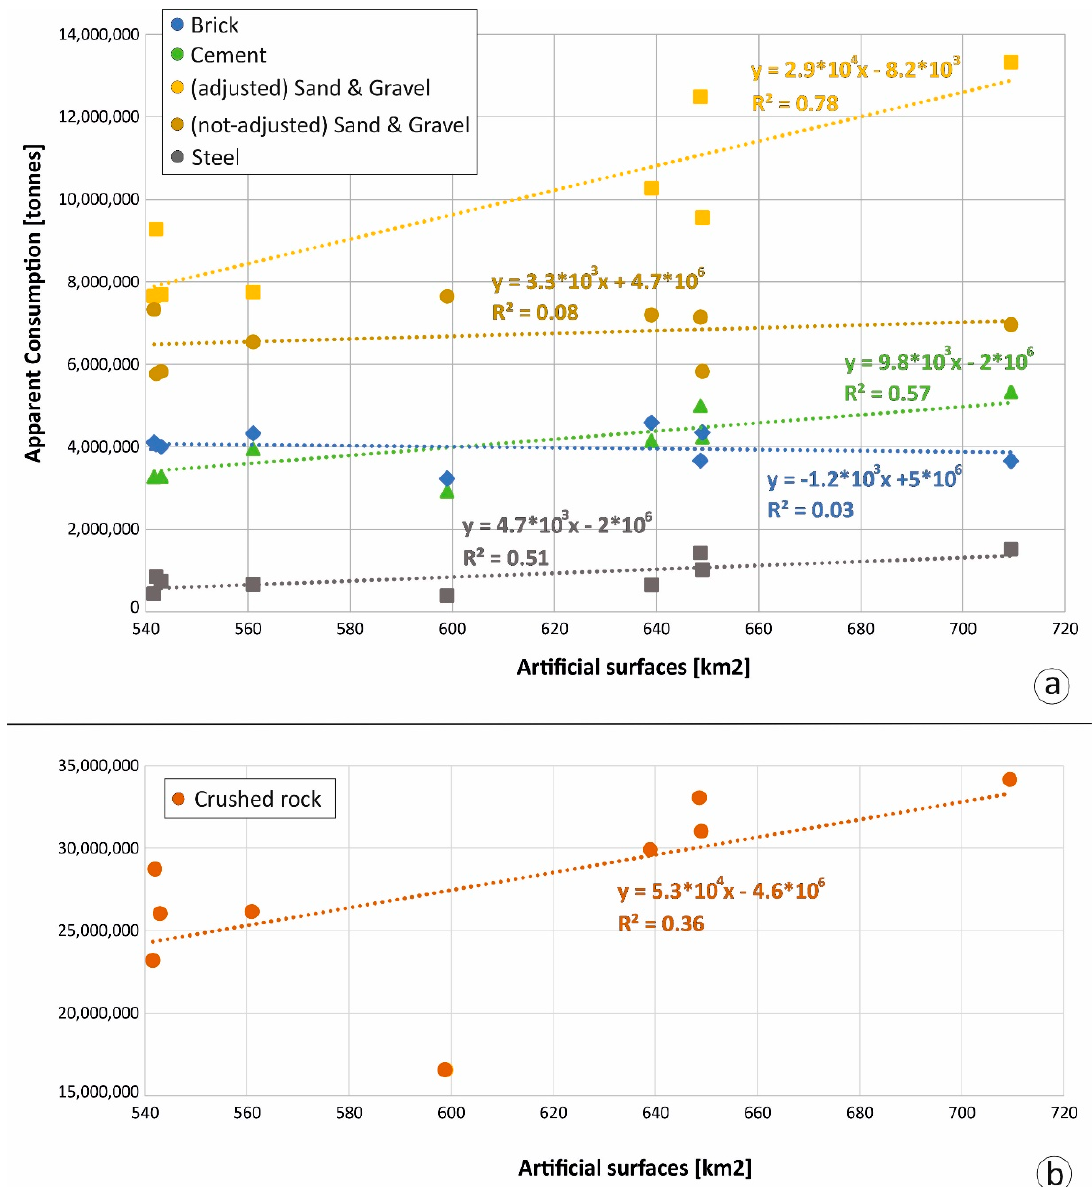
Figure 7. Correlation between artificial surfaces and AC of bricks, cement, (adjusted) sand & gravel, (not-adjusted) sand and gravel and steel ( a ) and crushed rock aggregates ( b ). Note: a different scale for the consumption projection of crushd rock is used. Linear fitting equations and R 2 values for each variable are provided.